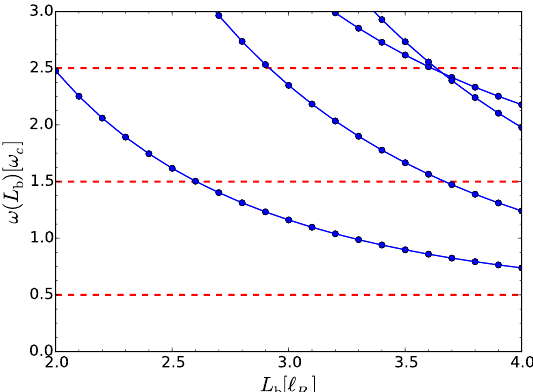
Figure 8: Discrete energy spectra of decoupled, i.e., isolated bays as function of their size L are rendered by blue solid lines and blue symbols for (cid:96) lines indicate the equidistant Landau levels in the bulk for